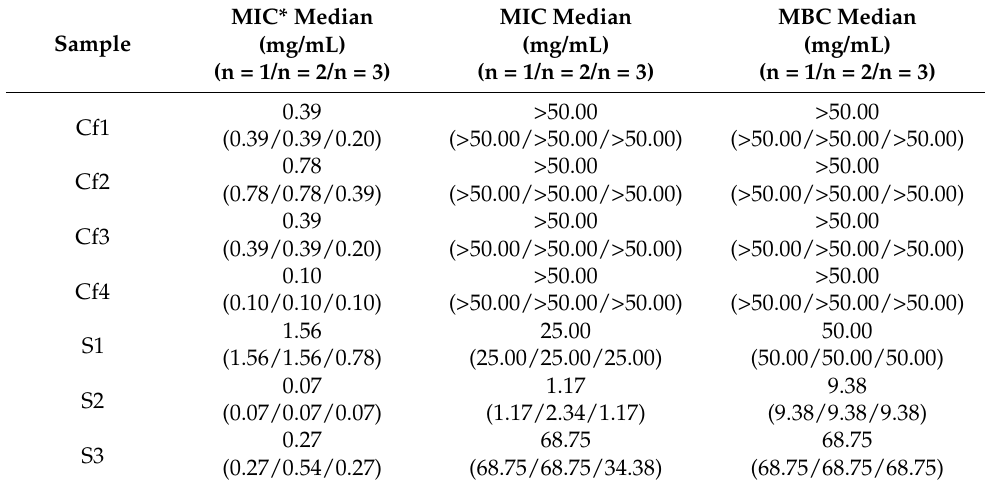
Table 3. Antibacterial activity of codfish and sardine extracts against S. aureus